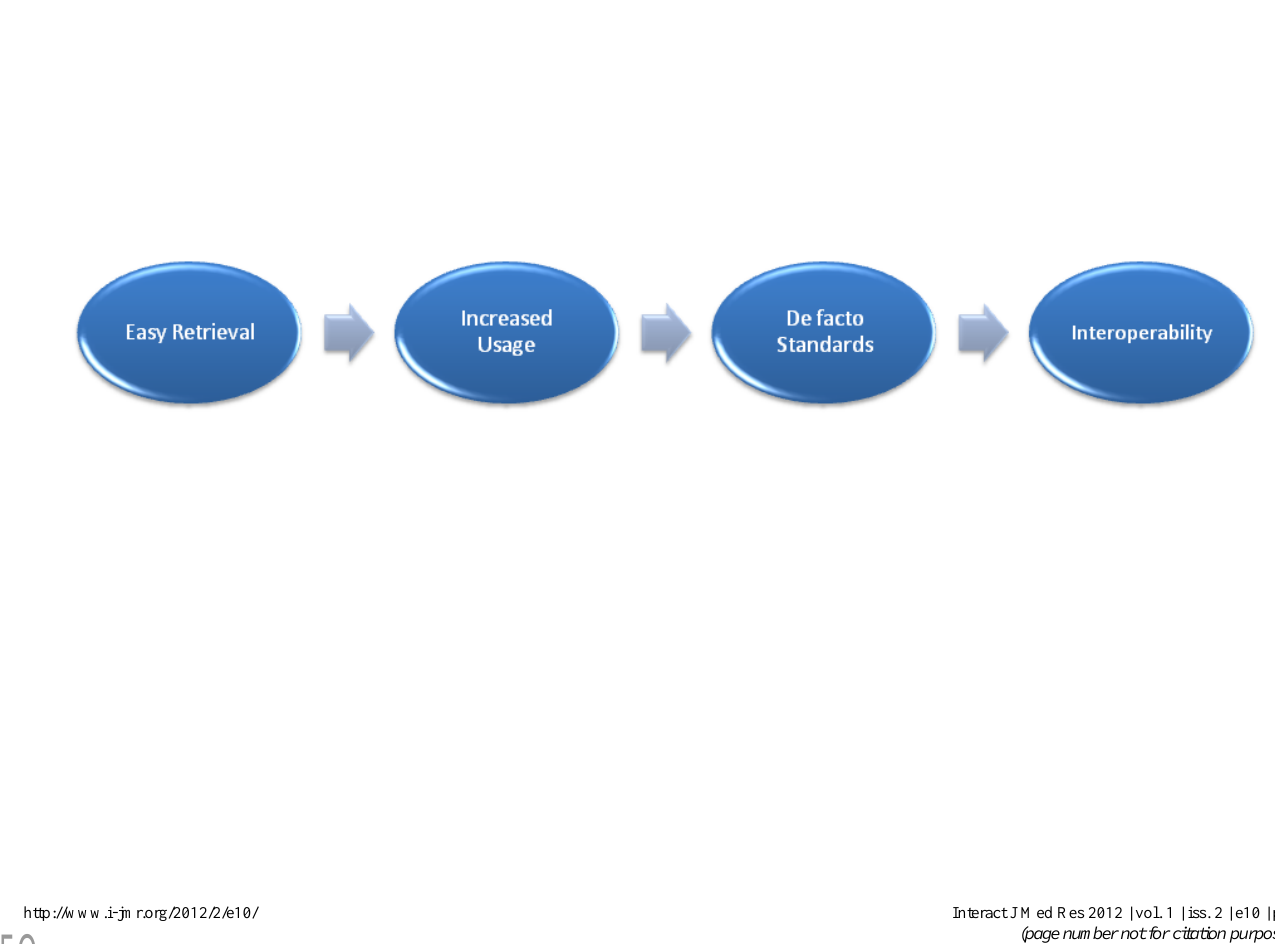
Figure 1. Theory of PRISM design to